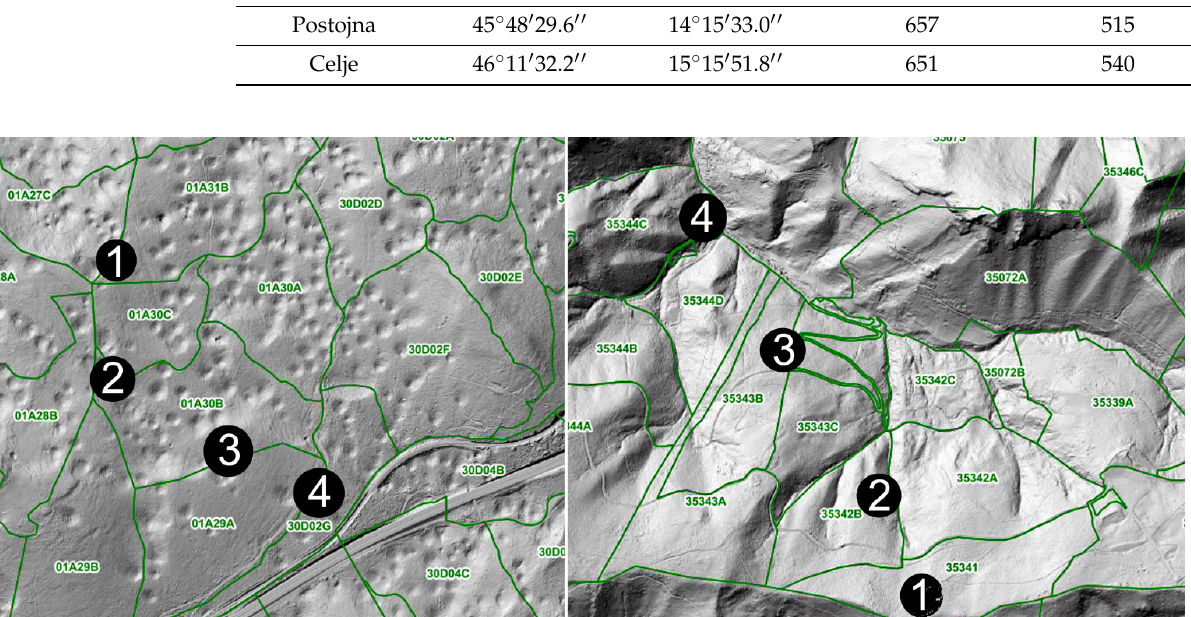
Figure 2. Location of micrometeorological stations, arranged from the locally highest (1) to the lowest (4) elevation at the Postojna ( left ) and Celje ( right ) research sites (M = 1:1000; source: Slovenia Forest Service).